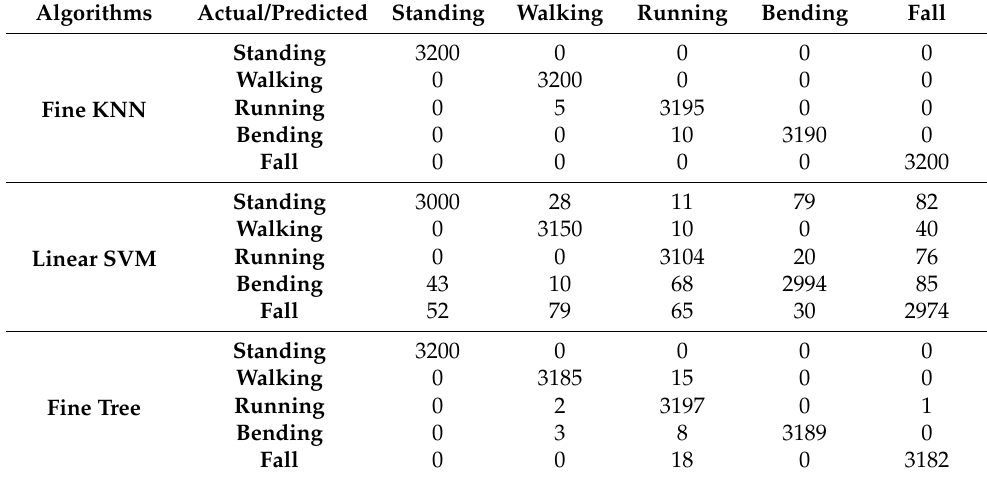
Figure 7. WCSI amplitude response of fall activity experiment. Table 6. Confusion matrix of machine learning algorithms on physical activities data.